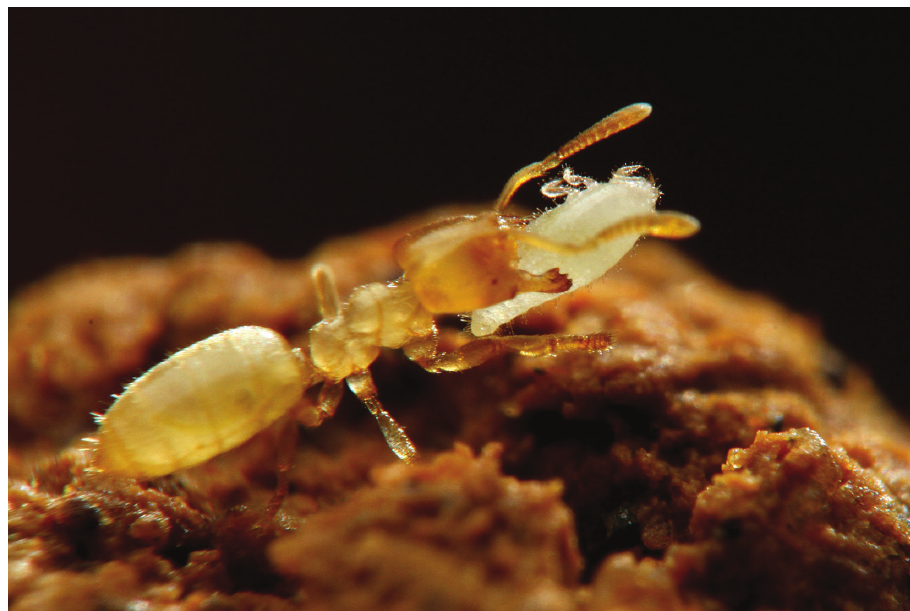
Figure 2. An adult female of Ishigakicoccus shimadai sp. n. being carried by Acropyga yaeyamensis . setose setae, 10.5–37.4 µm long, each with a pointed apex. Both setae distributed in transverse segmental bands. Multilocular pores each about 2.9–3.7 µm in diameter, each with 5–6 loculi, frequently present and evenly distributed on all areas of venter. 3–5 locular pores, each 5.8–7.9 µm in diameter, without central hub, present on me- dial area of abdominal segments III–VI in transverse rows. A circulus, 10.5–18.4 µm long and 21.0–33.2µm wide present on medial anterior border of abdominal segment II. Tritubular and bitubular pores absent. Oral collar tubular ducts